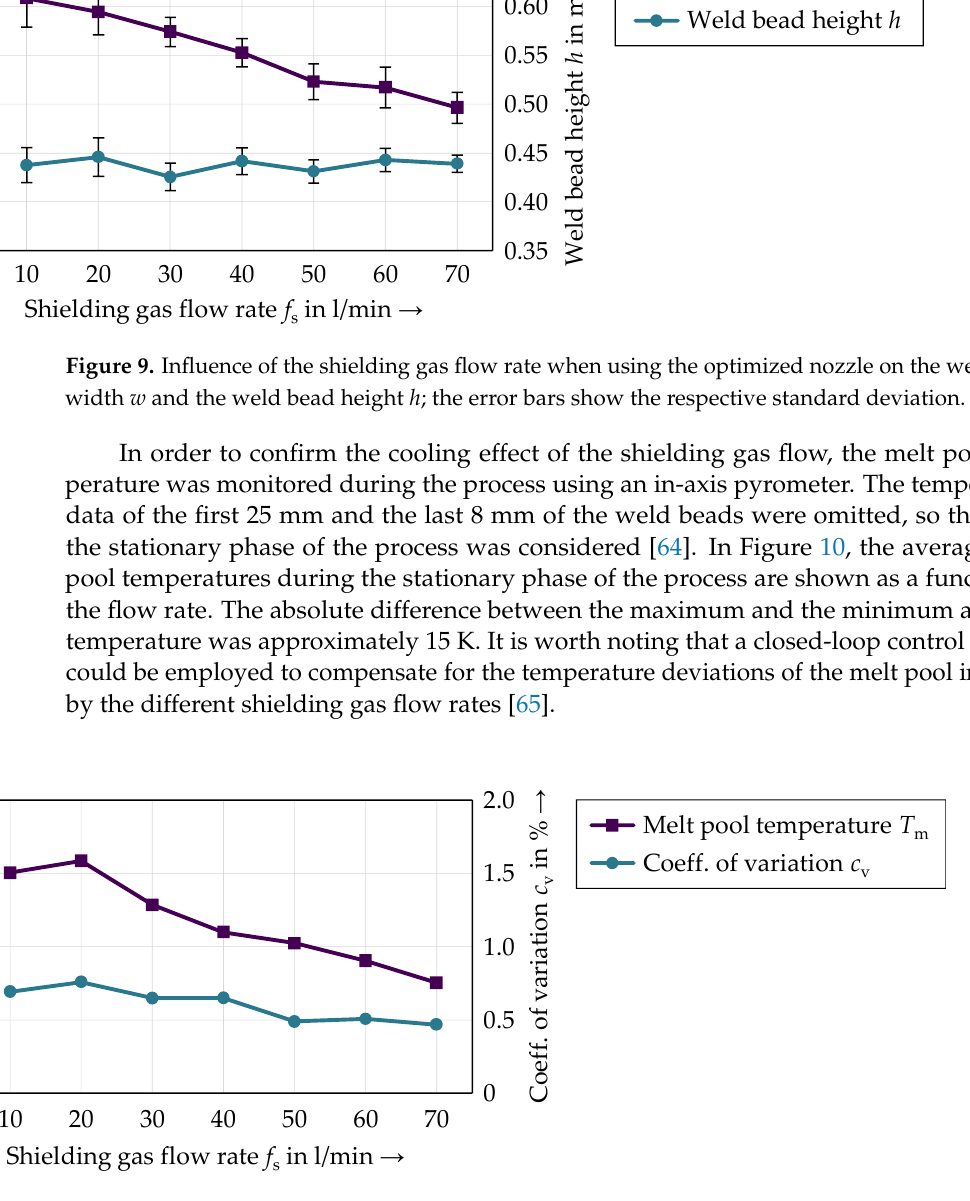
Figure 10. Influence of the shielding gas flow rate when using the optimized nozzle on the average melt pool temperatures T m during the stationary phase of the process and the coefficients of variation c v of the melt pool temperature signals.